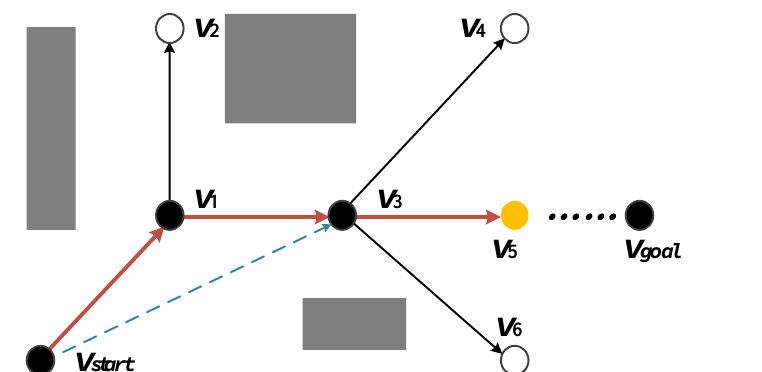
Figure 3. The planning process of LLA* ( v 5 is to be extended). Firstly, perform LoS-Check between v 3 (parent of v 5 ) and v start (grandparent of v 3 ). Then, use the updated g ( v 3 ) to only update g ( v 5 ) , making g ( v 5 ) even less than g ( v 4 ) and g ( v 6 )